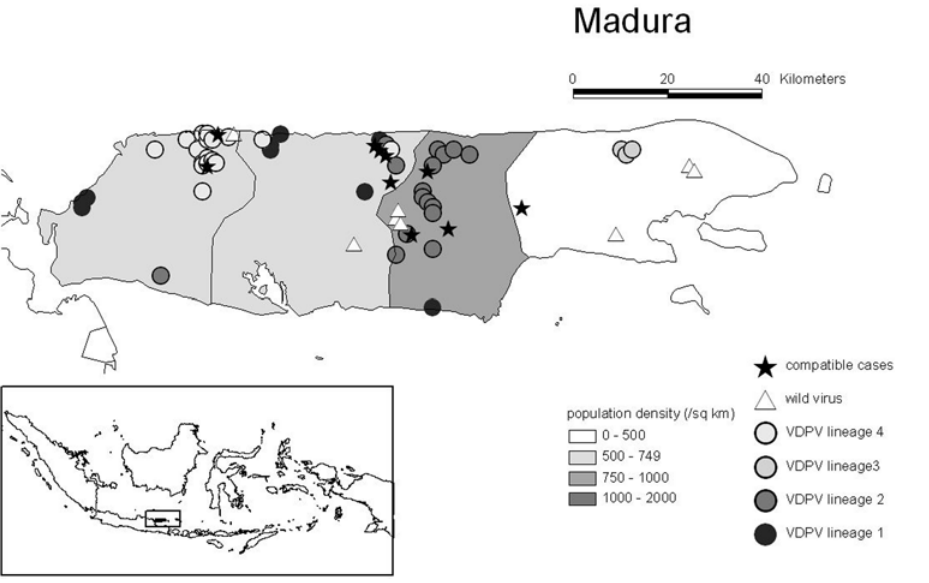
Figure 3 . (adaptedfromFig1;Estivarizetal.2008JID197:347–354) Geographic distribution of virologically-confirmed and polio- compatible type 1 cVDPV cases on Madura, Indonesia between June and October 2005. Population density in Madura for 2005 is shown by district